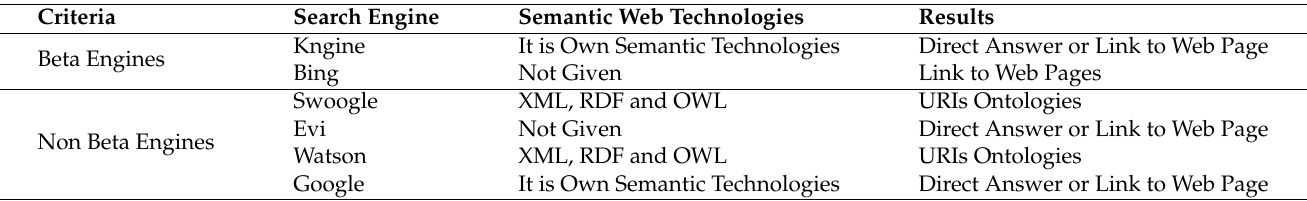
Table 1. Comparison between semantic search